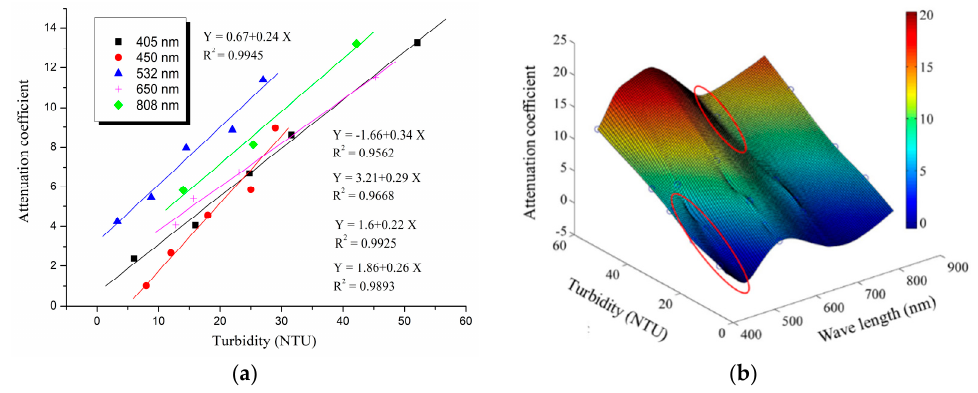
Figure 5. Attenuation coefficient—turbidity curve in clay dissolution medium: ( a ) Two dimension; ( b ) Three dimension